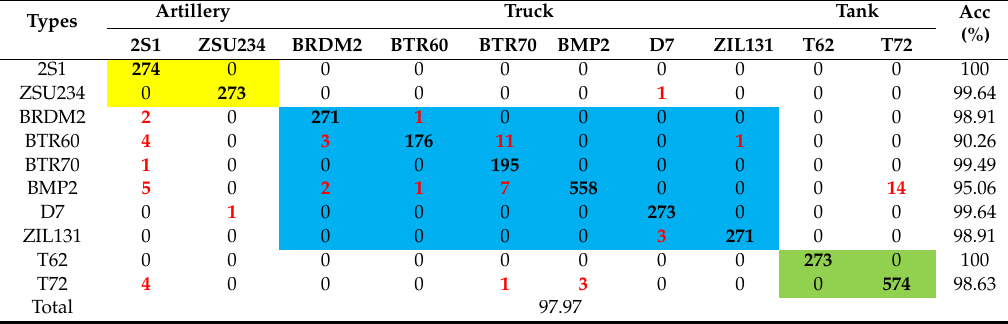
Table 7. Confusion Matrix of our method on 10-class MSTAR dataset under